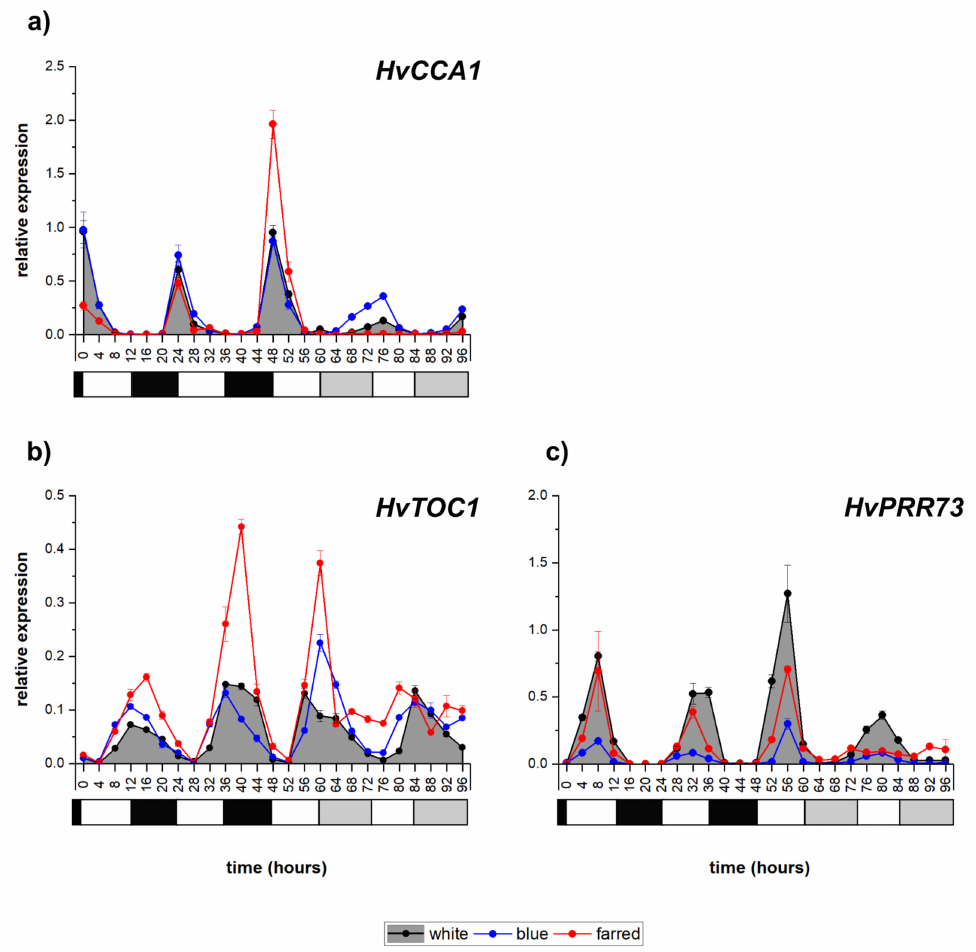
Figure 2. Expression patterns of barley circadian clock genes HvCCA1 ( a ), HvTOC ( b ) and HvPRR73 ( c ) with white, blue and far-red illumination. Calculating methods and the legends of graphs are the same as described in Figure 1. The following significant differences were calculated at p ≤ 5% level: HvCCA1 —0.16; HvTOC —0.023; HvPRR73